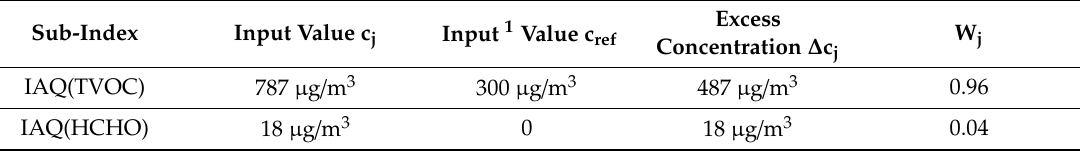
Table 6. Calculation of the weights of the W TVOC and W HCHO values for the two sub-indices of the combined IAQ(VOC)